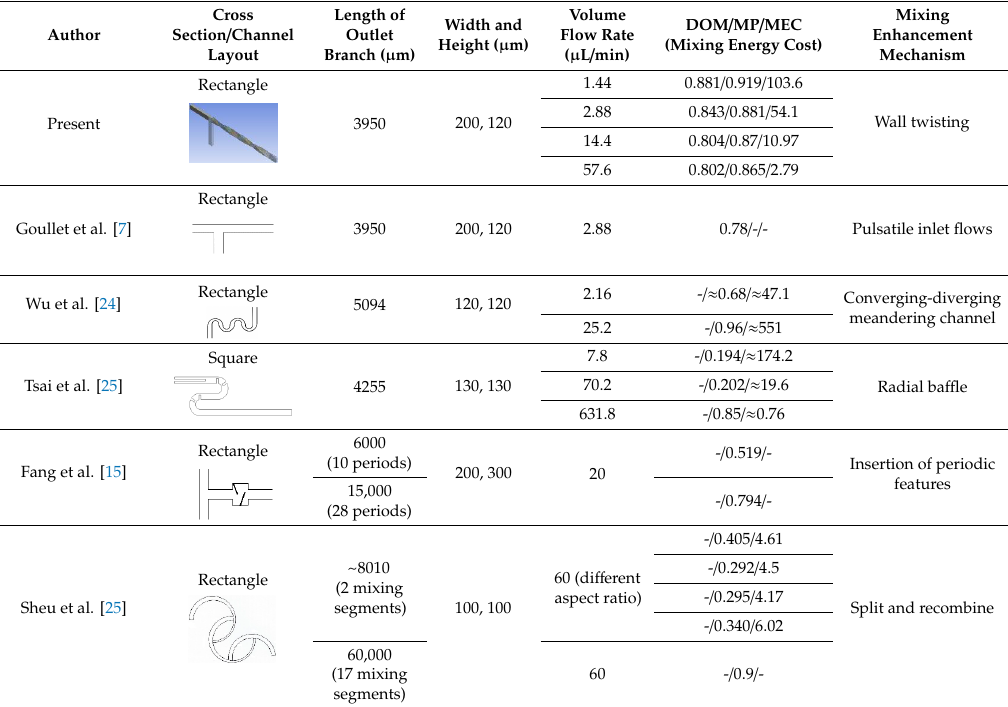
Table 1. Comparison of mixing performance.